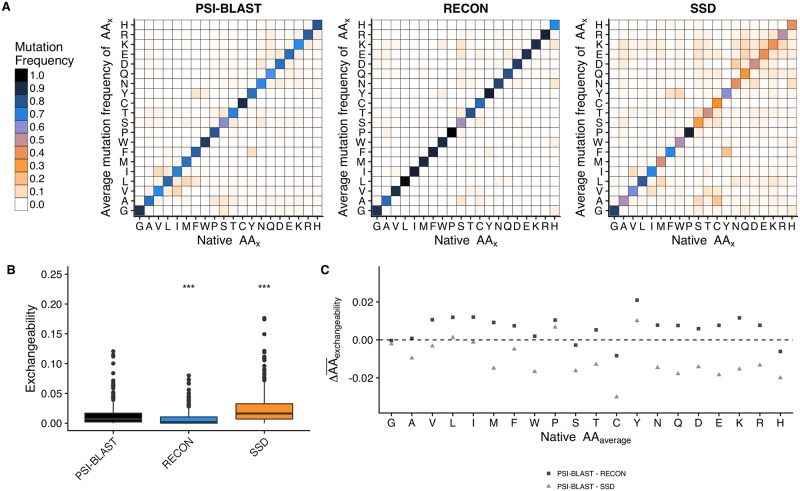
Comparison of exchangeability rates.(A) Average amino acid exchangeability of PSI-BLAST, RECON MSD, and SSD sequence profiles. Single-letter amino acid codes were used for both x and y axes, with the x axis representing the original amino acid and the y axis representing the average mutation frequency the original amino acid to the indicated mutation. (B) Comparison of exchangeability rates between profiles, excluding rates of native sequence conservation rates. The y axis represents the mean frequency a native amino acid is replaced with a specific, non-native amino acid, which we term as amino acid exchangeability. (C) Difference of mean amino acid-specific exchangeability observed in a PSI-BLAST profile compared to a design profile. The x axis represents each type of amino acid present in the native sequence. The y axis represents the difference in average exchangeability frequency of each amino acid type, or rather, the average frequency a native amino acid type is replaced with any other non-native amino acid. A positive value indicates the native amino acid is less likely to be exchanged for a non-native amino acid during design, whereas a negative value indicates the native amino acid is more likely to be exchanged, as compared to a PSI-BLAST profile.